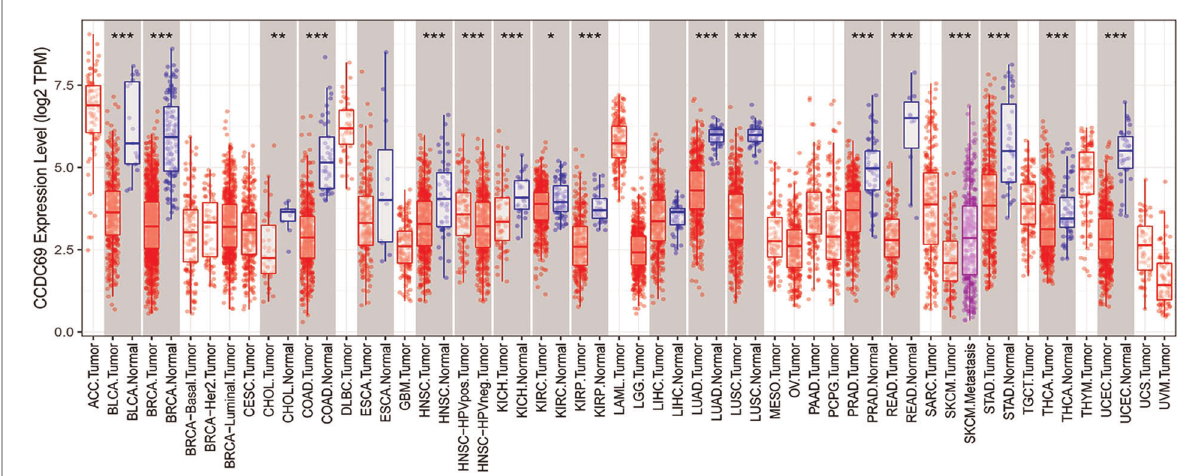
FIGURE 1 The expression level of CCDC69 in different human cancers. ( A ) The expression level of CCDC69 in different tumors in TCGA database was detected by TIMER. * P <0.05, ** P <0.01, *** P